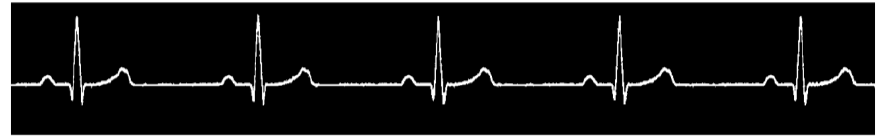
Figure 4. Example of the cropped image for one lead (Normal sinus rhythm, 60 bpm, II lead). B. Binary mask . The extraction of the binary masks has been inspired by the Math- Works Community [25]. Firstly, the image is converted from RGB to HSV. Then, in order to extract the signal from the rest of the image, three ranges of color (from 0 to 1) were chosen for each HSV channel: 0.000 ≤ 𝑝 𝐻 ≤ 0.997; 0.000 ≤ 𝑝 𝑆 ≤ 0.659; and 0.647 ≤ 𝑝 𝑉 ≤ 1.000, where 𝑝 𝐻 , 𝑝 𝑆 , and 𝑝 𝑉 are the values for each channel of the HSV space, within which, the pixels are considered to be part of the signal. The result is a black and white image (one per crop), as shown in Figure 5.